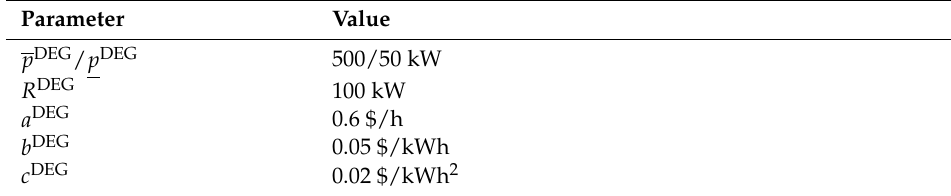
Figure 5. Demand forecast (black) and considered scenarios (blue) in simulations. Table 2. DEG data [25].